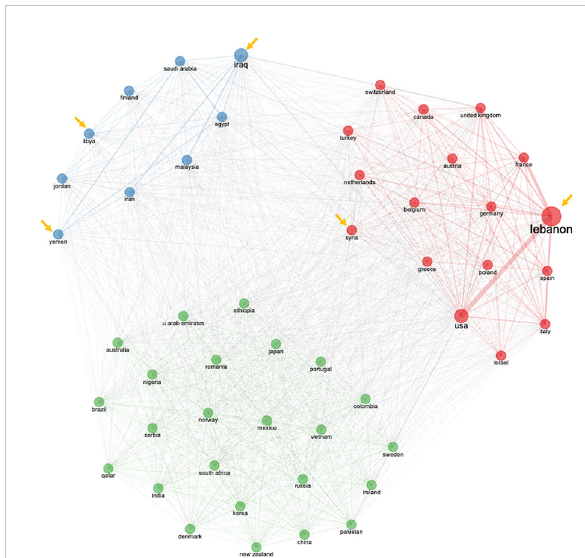
FIGURE 8 Country collaboration on cancer research in FCS in the MENA region from 2000 to 2021. The dimensions of the rectangles symbolize the number of cooperative partners, while the font size of the countries shows the number of their collaborations. Additionally, the closeness of the countries ’ partnership is re fl ected by the thickness of the lines. Arrows indicate the FCS countries included in this study.